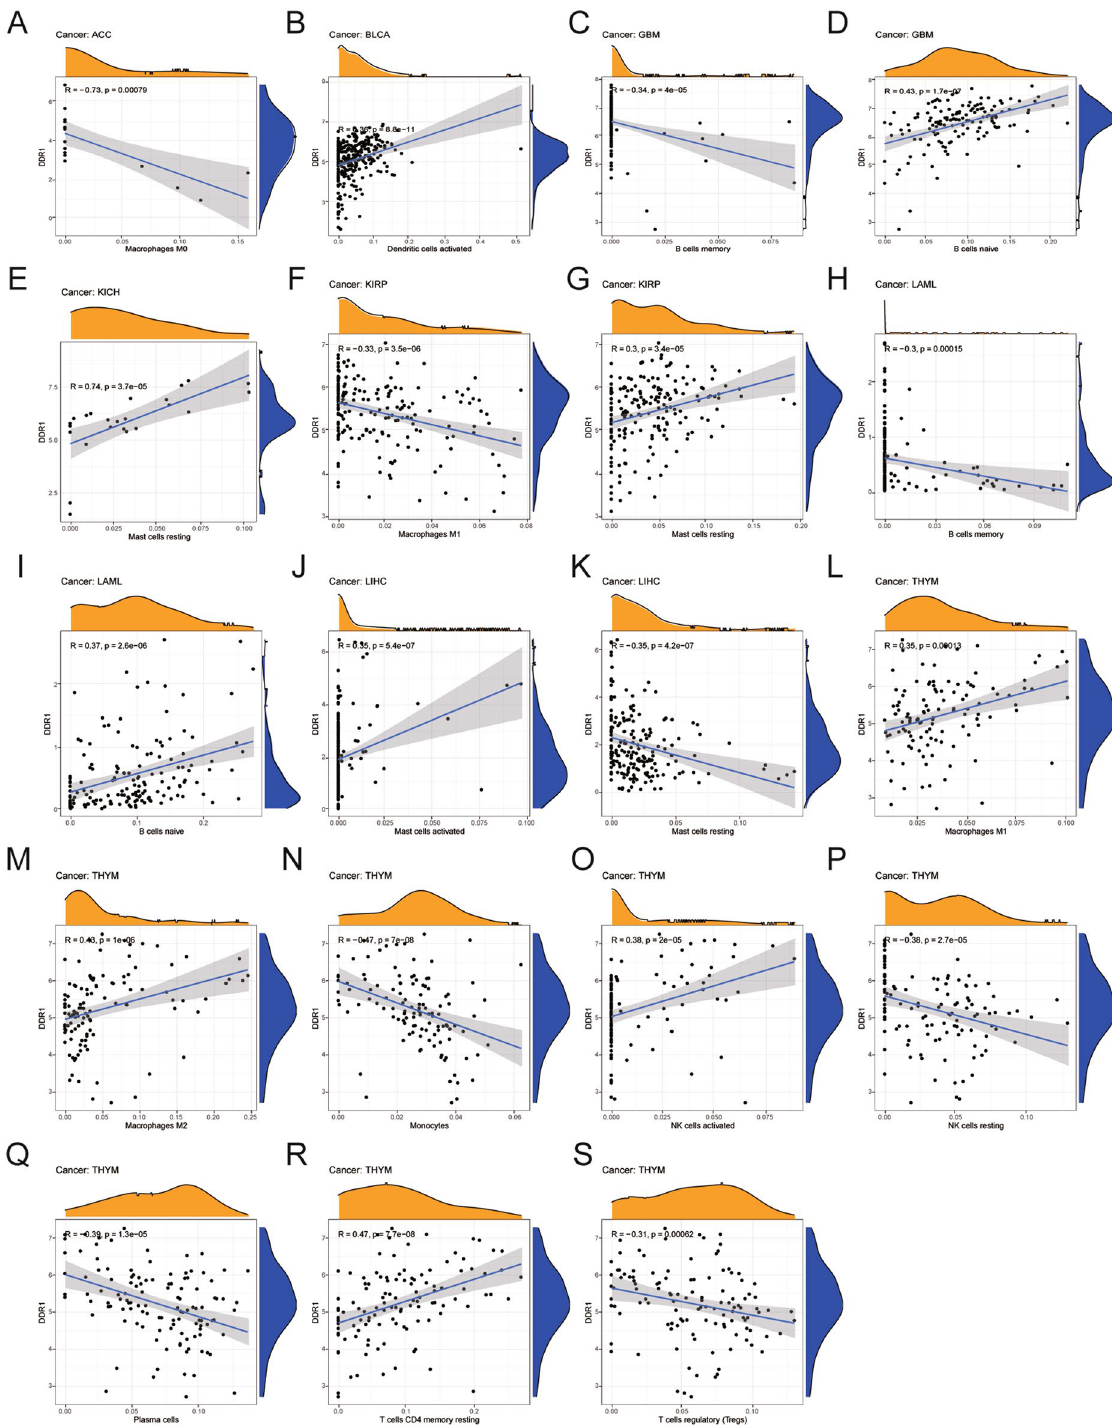
Figure 8. Relationship between DDR1 expression and tumor infiltration of different immune cells in the TCGA database. ( A–S ) Eight tumors with the highest correlation coefficients between DDR1 expression and immune- associated cell